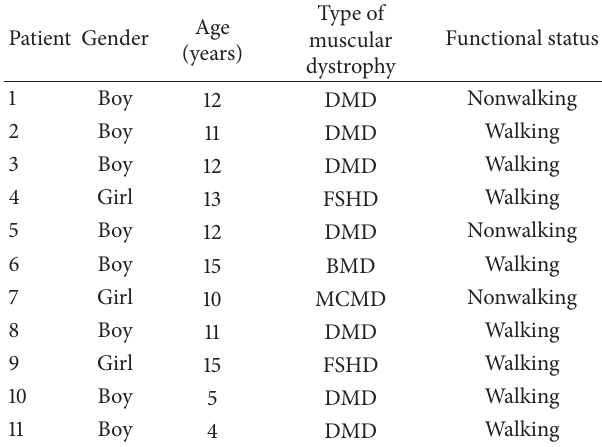
BMD: Becker musculardystrophy; DMD: Duchenne muscular dystro- phy; FSHD: Facioscapulohumeral muscular dystrophy; MCMD: Merosin - negative congenital muscular